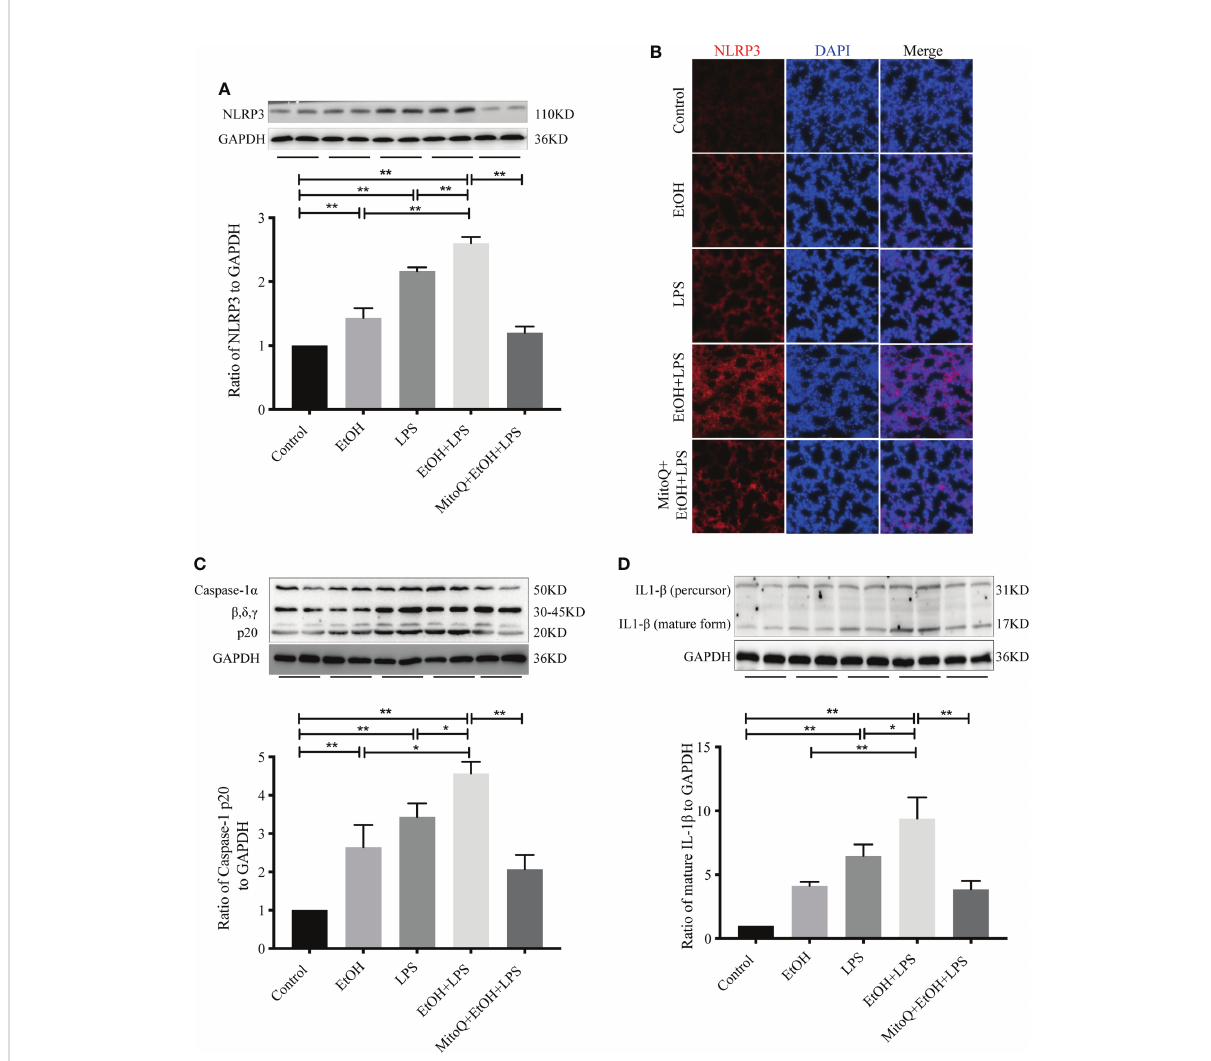
FIGURE 3 MitoQ decreased ethanol-LPS-induced NLRP3 in fl ammasome activation. (A – D) Effect of NLRP3/IL-1 b Signaling pathways in the model of C57BL/6 mice. NLRP3 (A) , Caspase-1 (C) , and IL-1 b (D) in lung tissue total proteins were detected by western blotting. (B) Protein NLRP3 (red) activation on the lung tissue section was analyzed by immuno fl uorescence (magni fi cation 400×). All data were presented as mean ± SEM (n=6 in each group), *P < 0.05, **P <